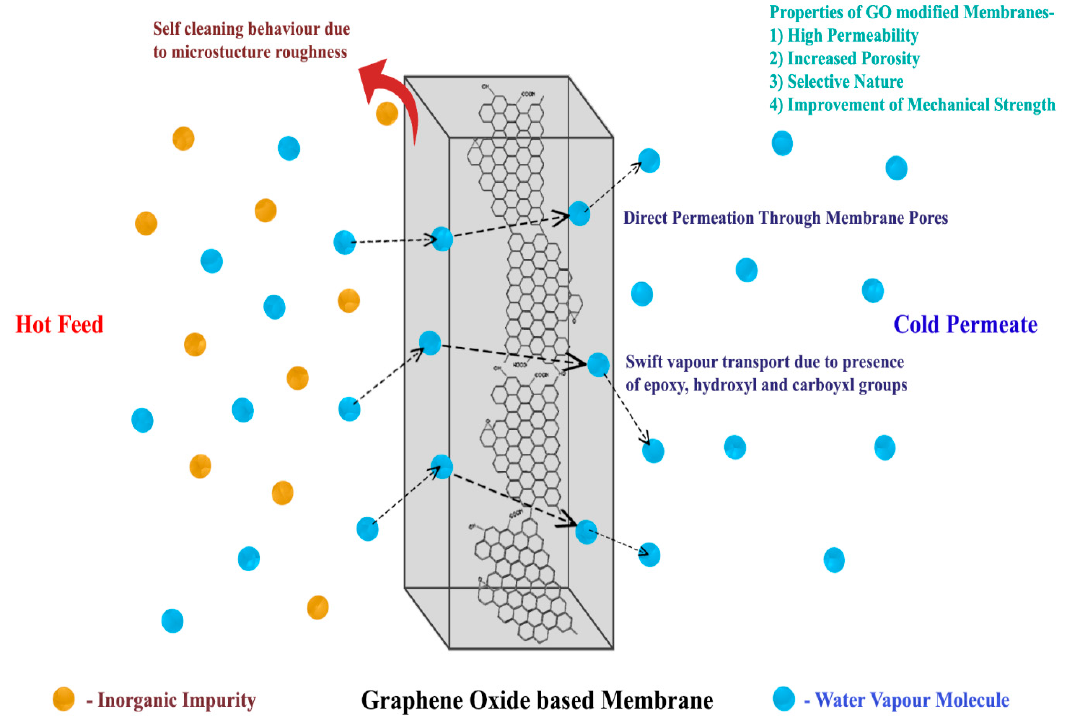
Figure 9. Property enhancement in MD membranes due to addition of graphene oxide nanoparticles.